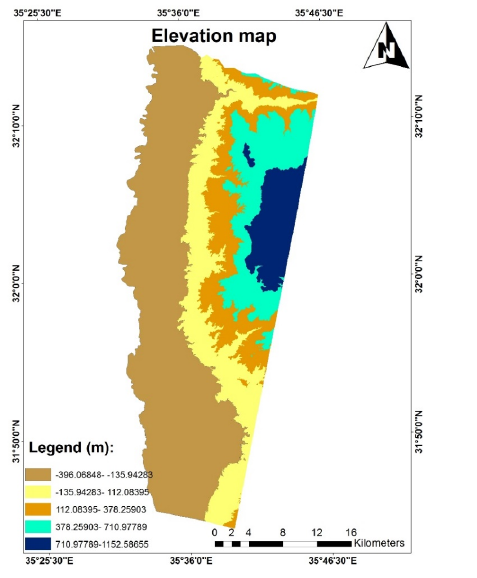
Fig. 5. Elevation map of the study area Fig. 6. Aspect map of the study area